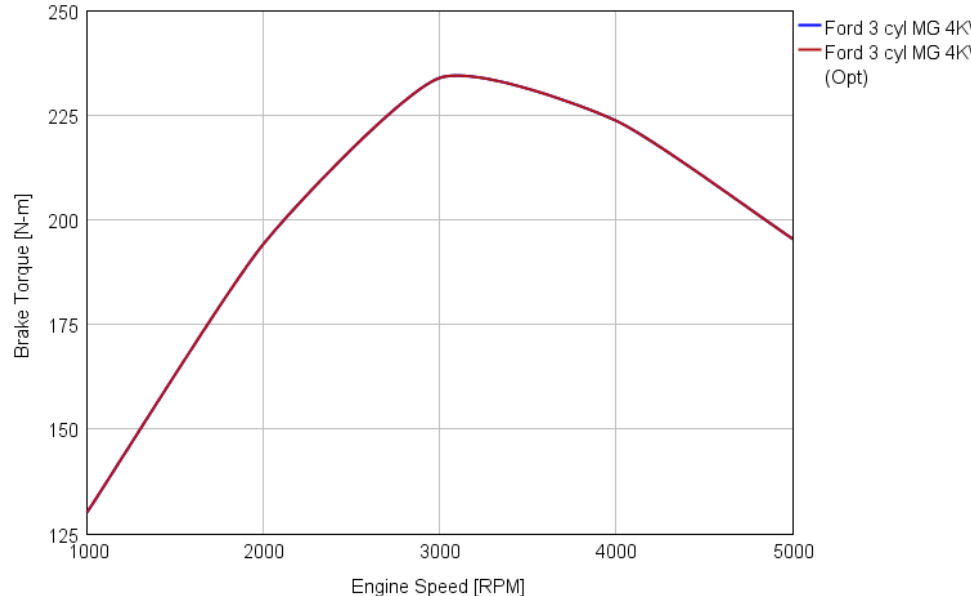
Figure 24. Brake torque of the electrically-assisted turbocharger (EAT) 3 kW model for the initial and optimized compressor.